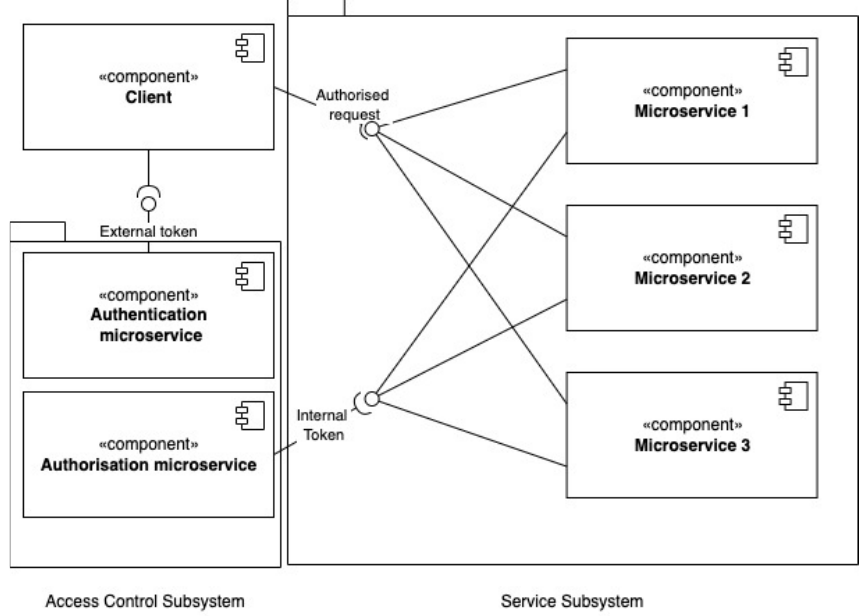
Figure 4. Diagram of the components for the proposed decentralized access control in